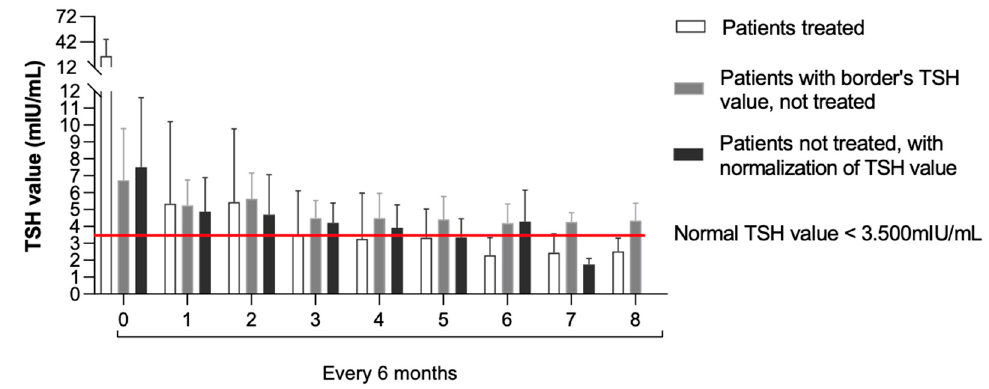
Figure 1. TSH levels’ trend evaluated every six months until 4 years of age among the three groups.